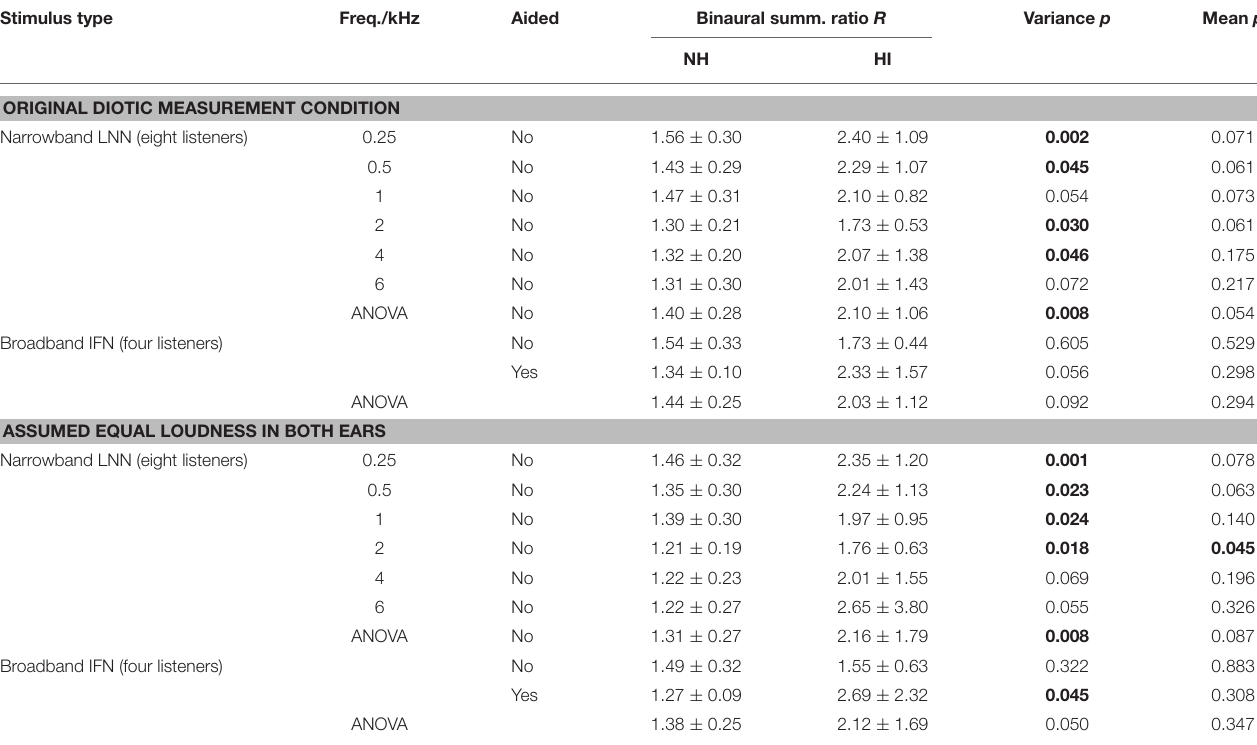
TABLE 1 | Binaural summation ratios R averaged (mean ± standard deviation) across listeners of Dataset 1 (column 4: NH, column 5: HI) and across categories (15–50 CU). Stimulus